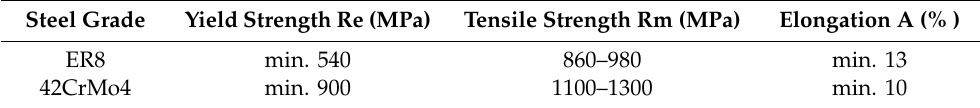
Table 2. Mechanical properties of ER8 and 42CrMo4 steels.